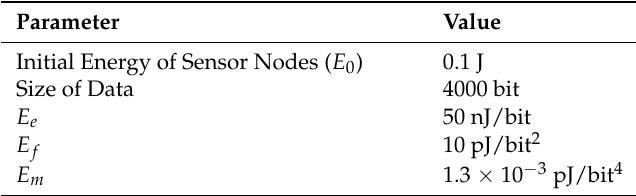
Table 1. Parameters and their values of the wireless sensor network